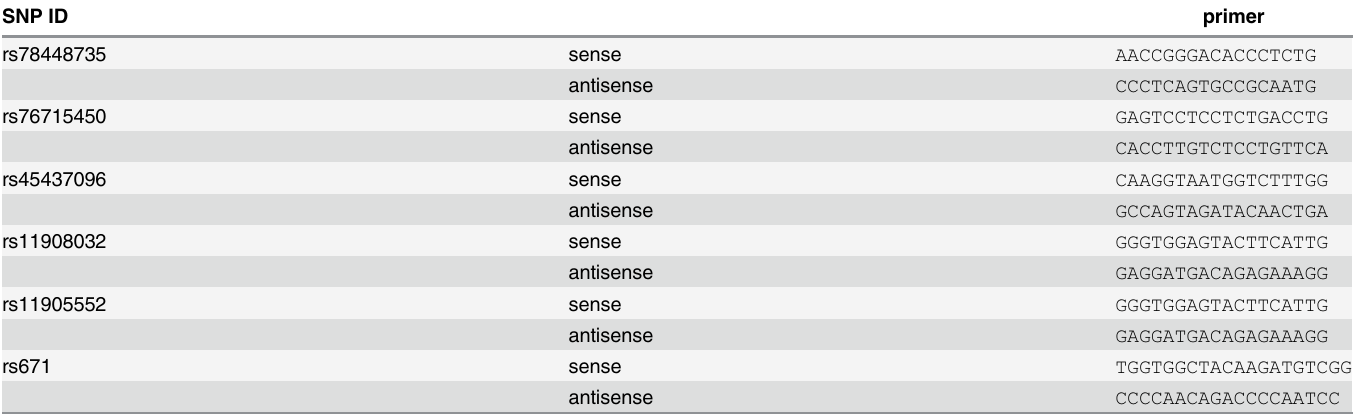
Table 2. Primer sets for obtaining positive controls for SNP genotyping.